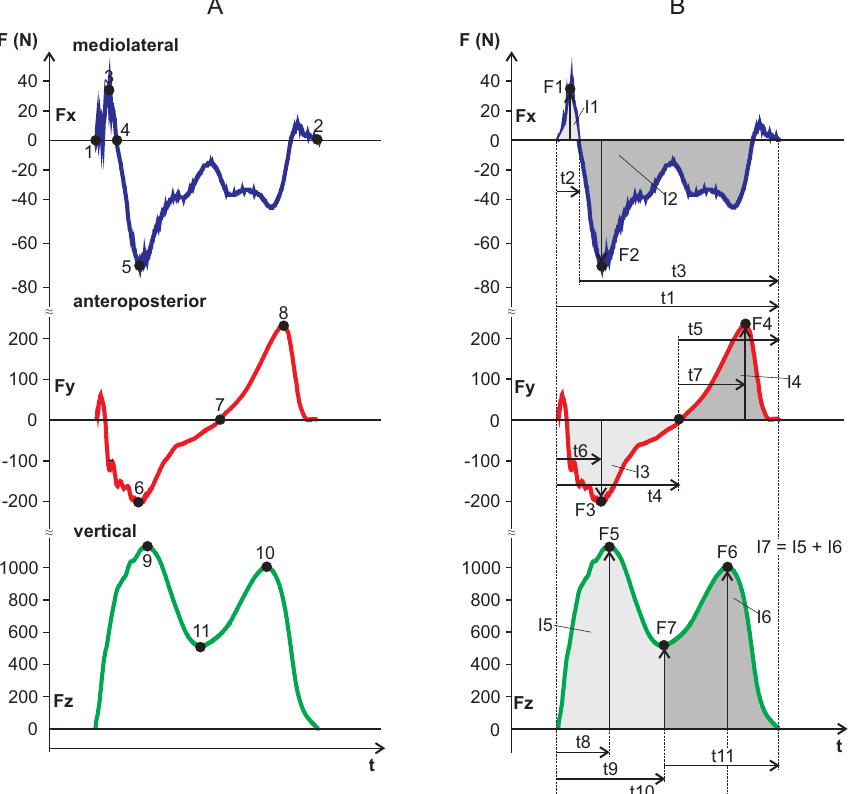
Figure 1. The ground reaction force during the stance phase of one step (A). Graphical illustration of temporal and force variables of the three GRF components (B). t1 = duration of stance phase; Fx – mediolateral component: F1 = lateral peak, F2 = medial peak, t2 = duration of force acting in the lateral direction, t3 = duration of force acting in the medial direction, I1 = lateral impulse, I2 = medial impulse; Fy – anteroposterior component : F3 = braking peak, F4 = propulsive peak, t4 = duration of the braking phase, t5 = duration of the propulsive phase, t6 = time to braking peak, t7 = time to propulsive peak, I3 = braking impulse, I4 = propulsive impulse; Fz – vertical component: F5 = load- ing response peak, F6 = terminal stance peak, F7 = midstance valley, t8 = time to loading response peak, t9 = time to midstance valley, t10 = time to terminal stance peak, t11 = time from midstance valley to toe off, I5 = impulse of loading response and midstance, I6 = impulse of terminal stance and preswing, I7 = total impulse of the vertical GRF.